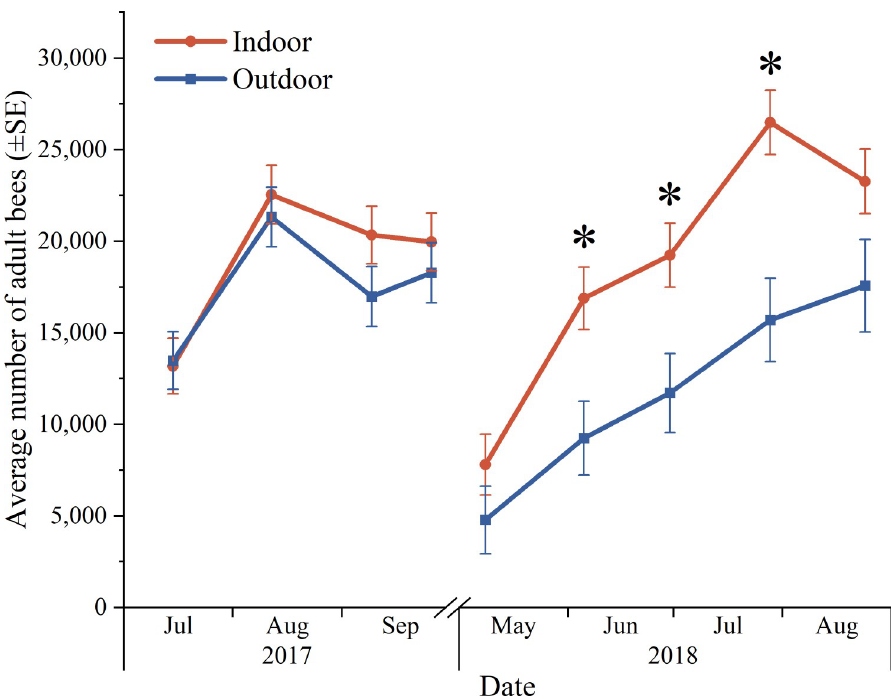
Fig 4. Influence of wintering method on average adult bee population (live colonies) over 23 months. Indoor represents colonies moved to an indoor wintering building, and outdoor represents colonies kept outdoors in insulating wraps. Asterisks indicate significant differences between wintering